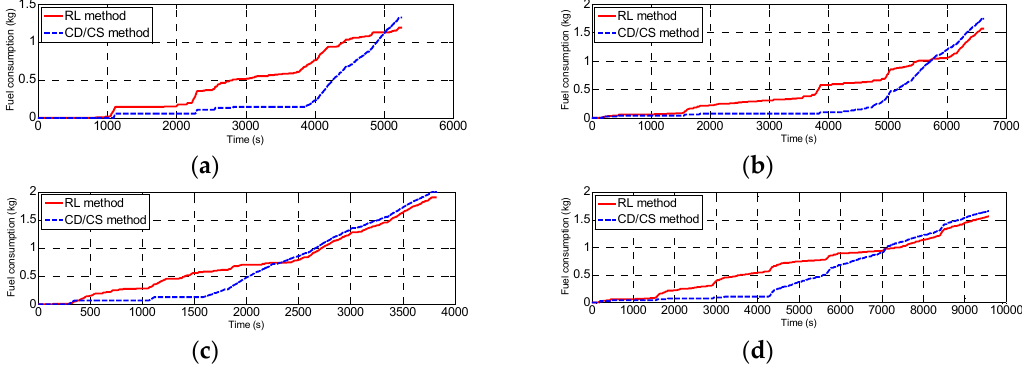
Figure 12. Fuel consumption results. ( a ) Cycle 1; ( b ) Cycle 2; ( c ) Cycle 3; and ( d ) Cycle 6.